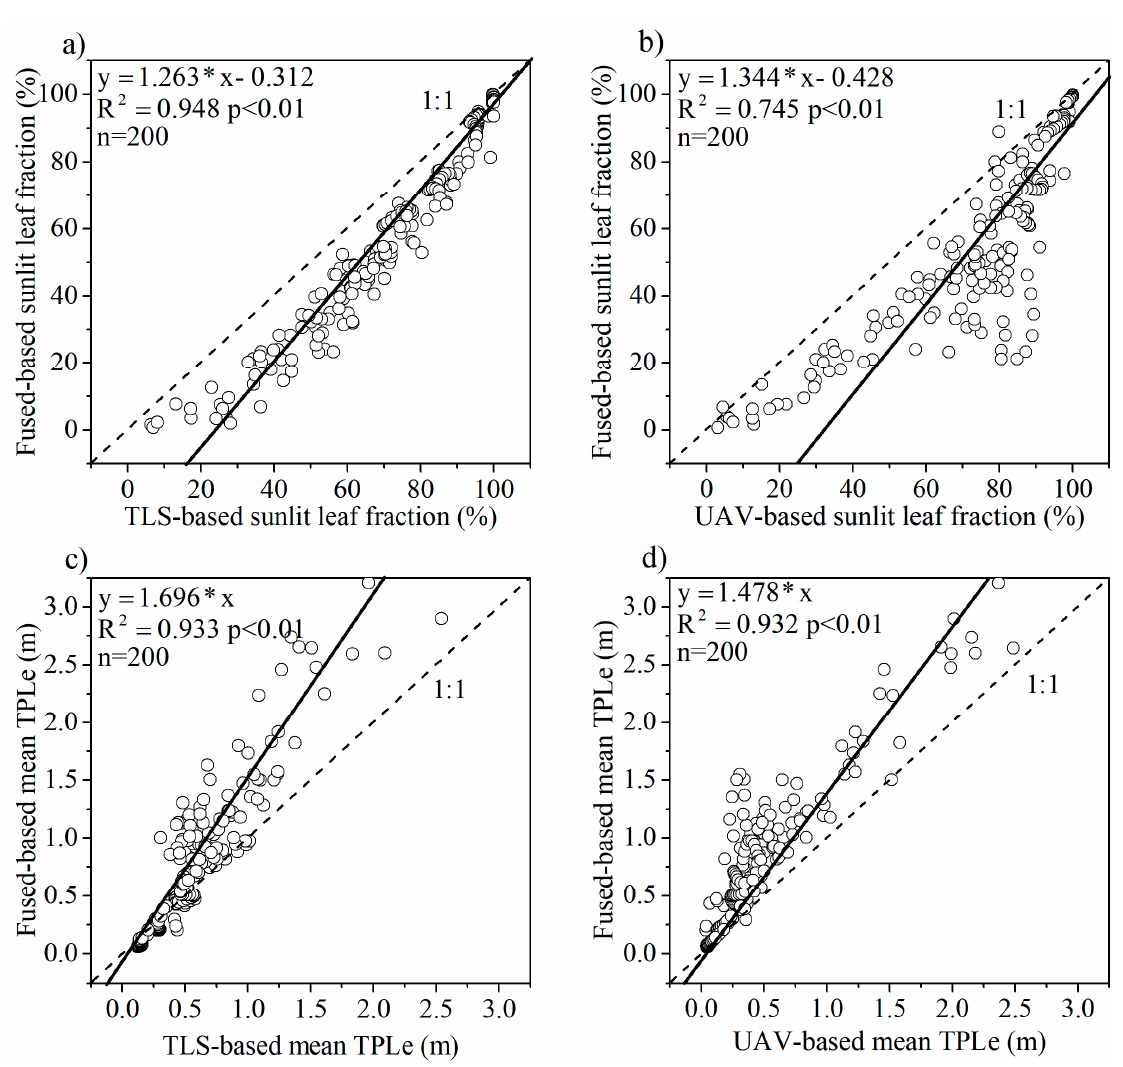
Figure 10. Comparisons between the TLS and UAV-based sunlit leaf fraction (insets a , b ) and mean effective total path length ( TPLe ) (insets c , d ) with the ones obtained from the fused point data.